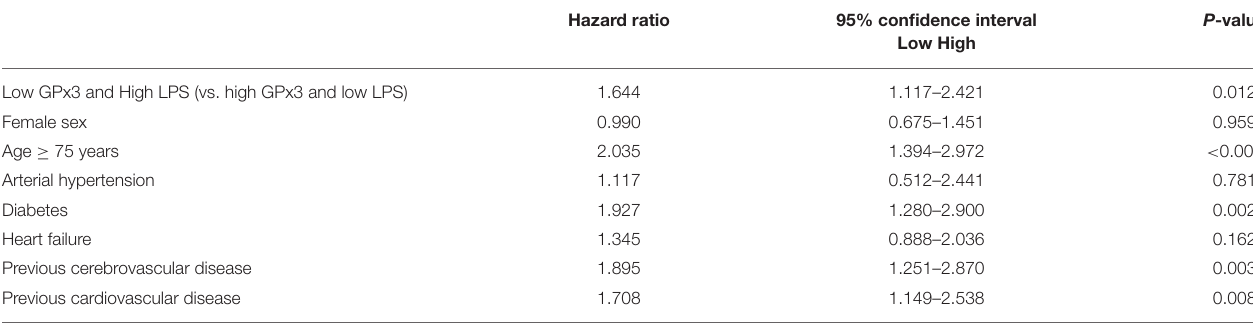
TABLE 3 | Multivariable Cox regression analysis of risk factors for cardiovascular